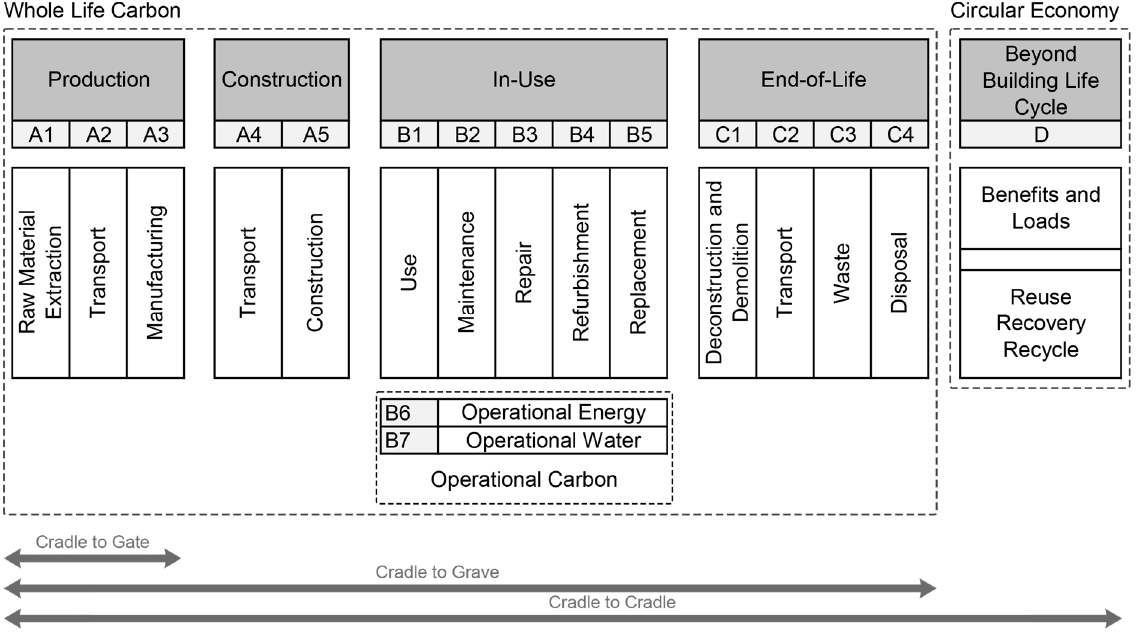
Figure 3. LCA Stages Based on EN 15978:2011.